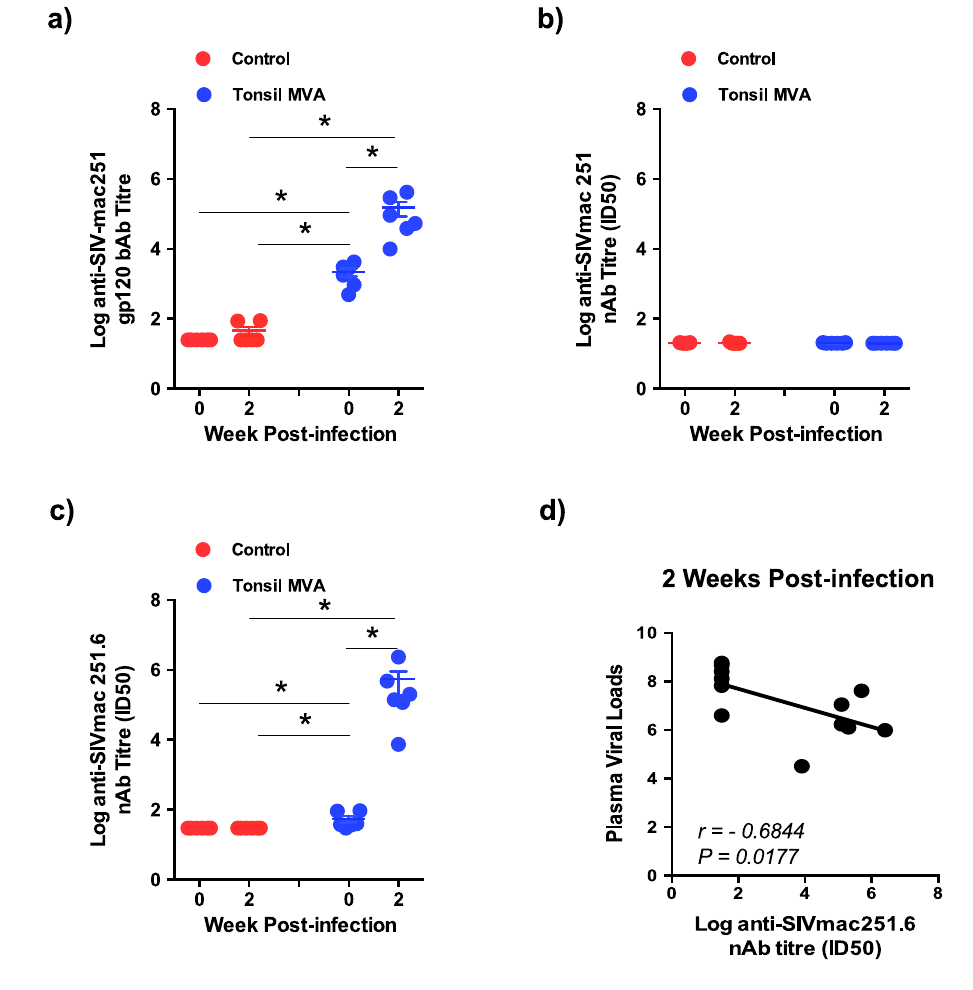
Fig. 3 | Tonsil vaccination induced signi fi cant levels of SIVmac251.6 neutraliz- ing antibodies that inversely correlated with plasma viral loads. SIVmac251 speci fi c ( a ) gp120 binding antibody (week 0 control vs week 2 control P =ns; week 0 control vs week 0 tonsil MVA P =0.0011; week 2 control vs week 0 tonsilMVA P =0.0011;week2controlvsweek2tonsilMVA P =0.0011;week0tonsil MVA vs week 2 tonsil MVA P =0.0011). Data are presented as mean values+/ –